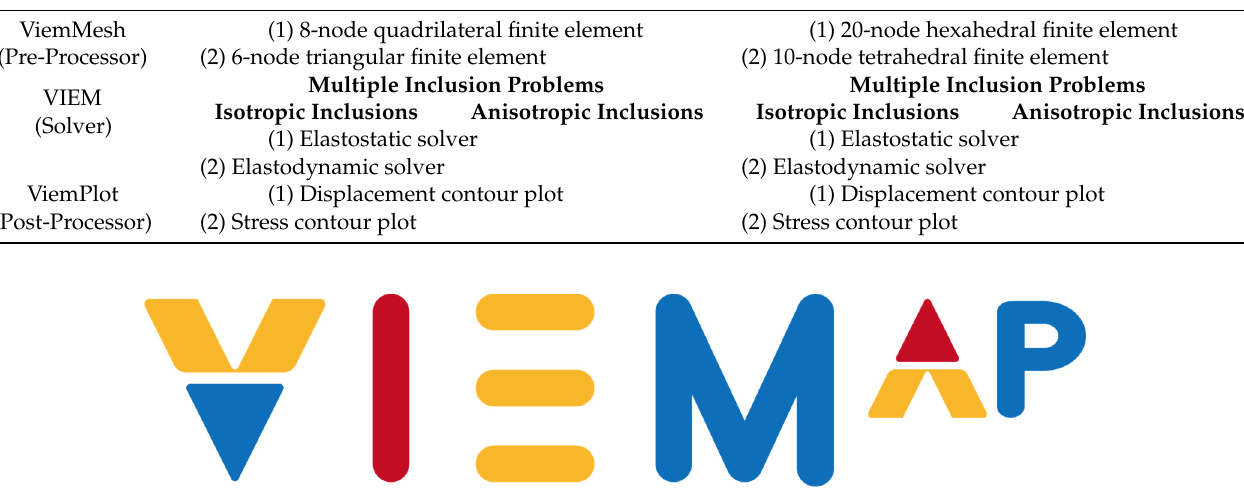
Figure 3. Registered trademark for VIEMAP.